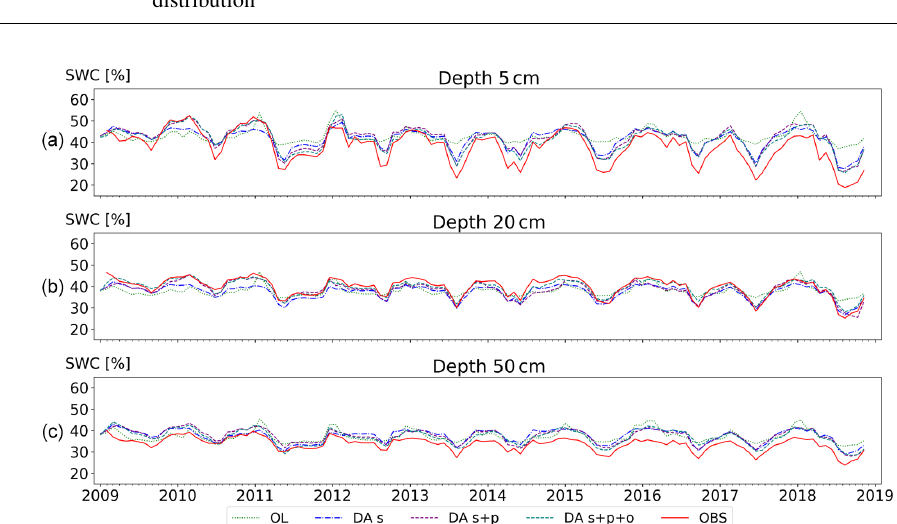
Figure 3. Time series of the monthly averaged soil water content (SWC) from 2009 to 2018 at the three different depths and for each simulation scenario. The subplots (a) , (b) , and (c) represent the three depths 5, 20, and 50cm, respectively. The red (solid) line shows observational data. The light green (dotted) line shows open-loop simulation results. The blue (dash-dotted) line shows results for data assimilation of state variables. The purple (dashed) line shows results for the assimilation of states and updating of parameters. The dark green (dashed) line shows results for assimilation of states and updating of parameters including organic